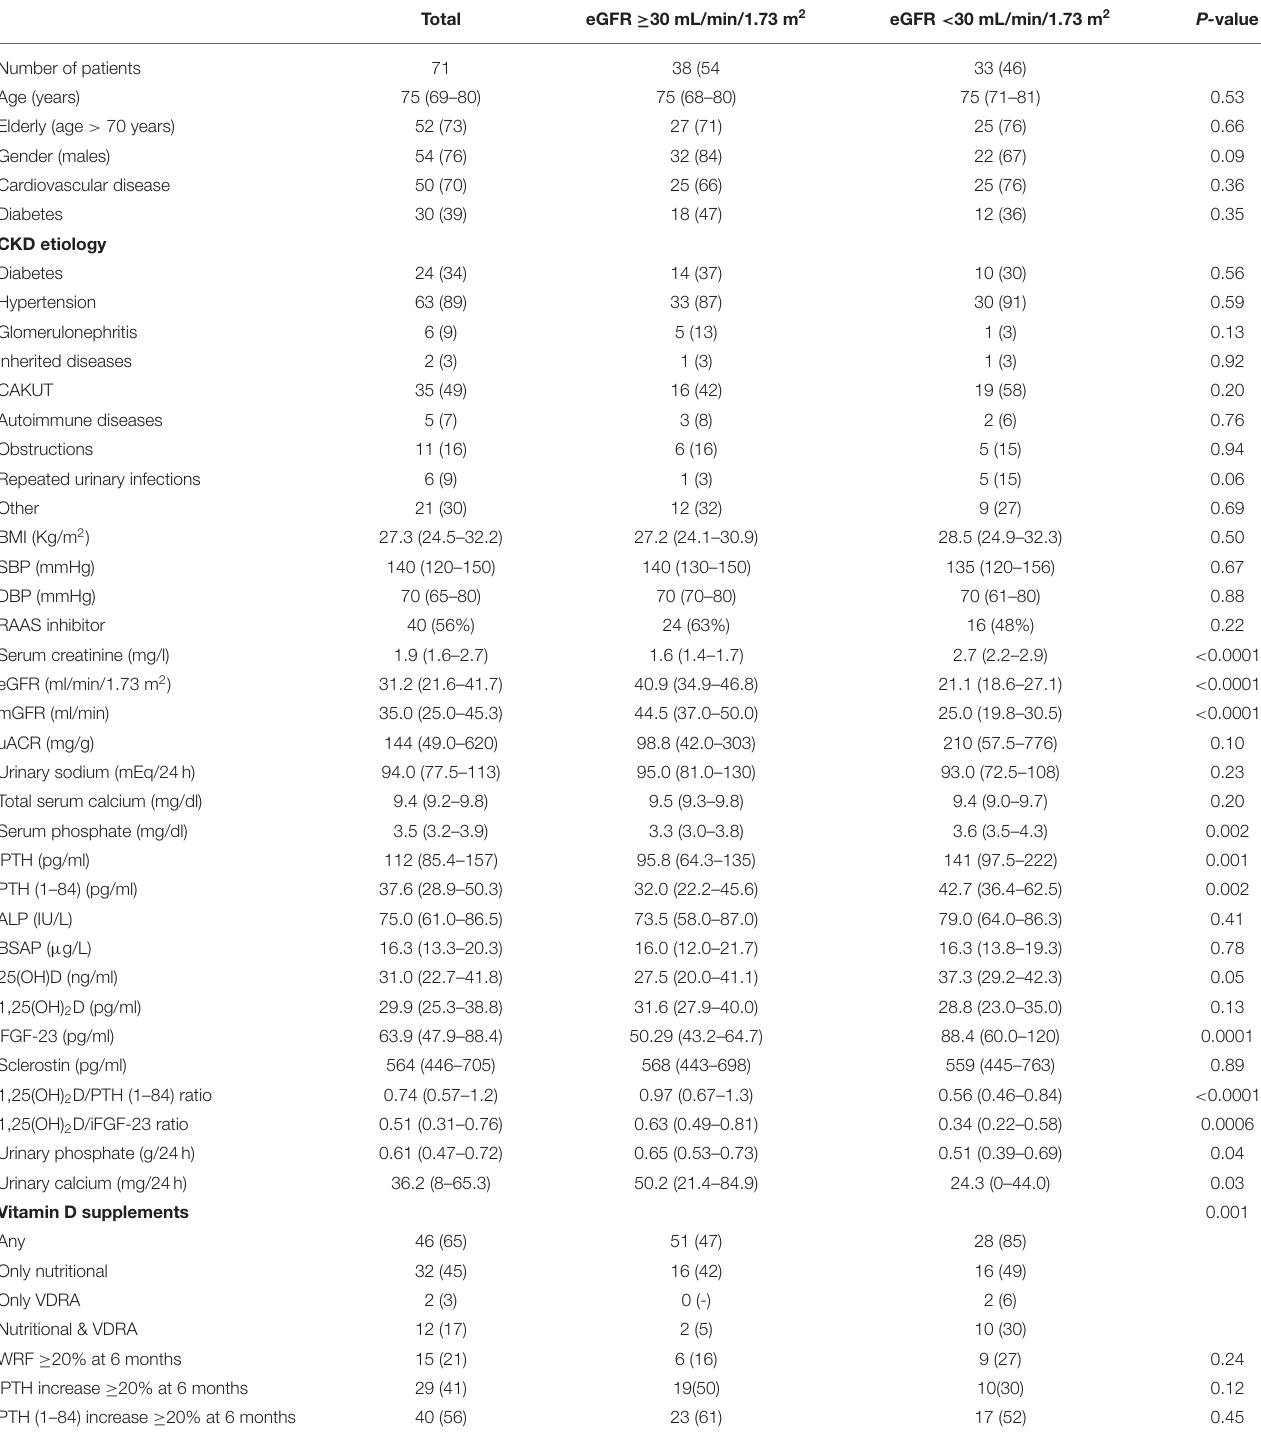
TABLE 1 | Baseline characteristics and study outcomes stratified according to basal